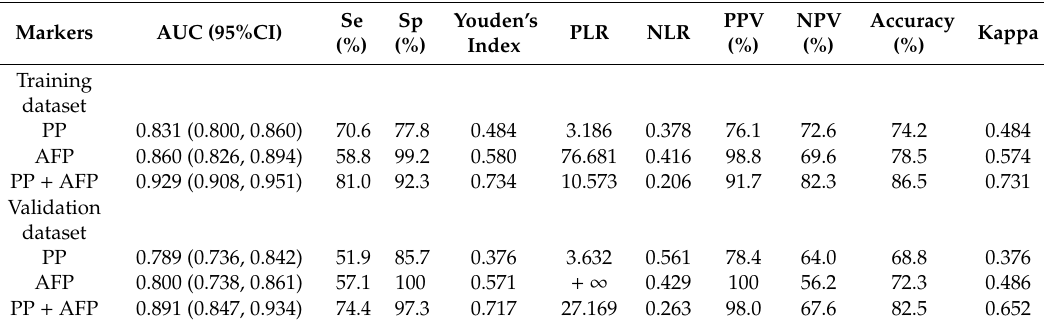
Table 2. The diagnostic value of PP, AFP, and their combination in the training dataset and validation